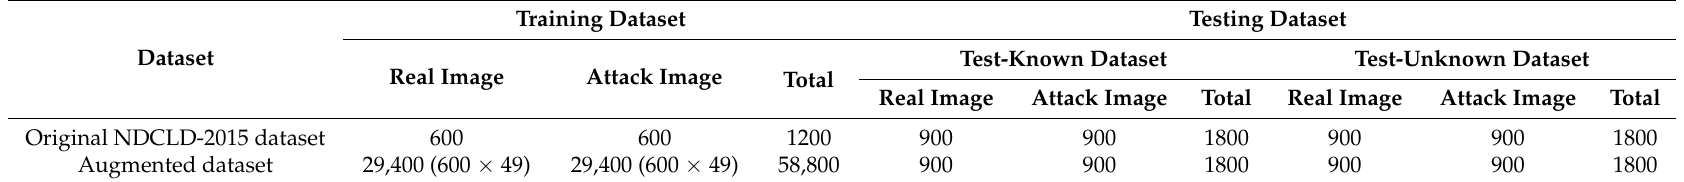
Table 6. Description of training and testing datasets with the NDCLD-2015 dataset using LivDet-Iris-2017 division method.